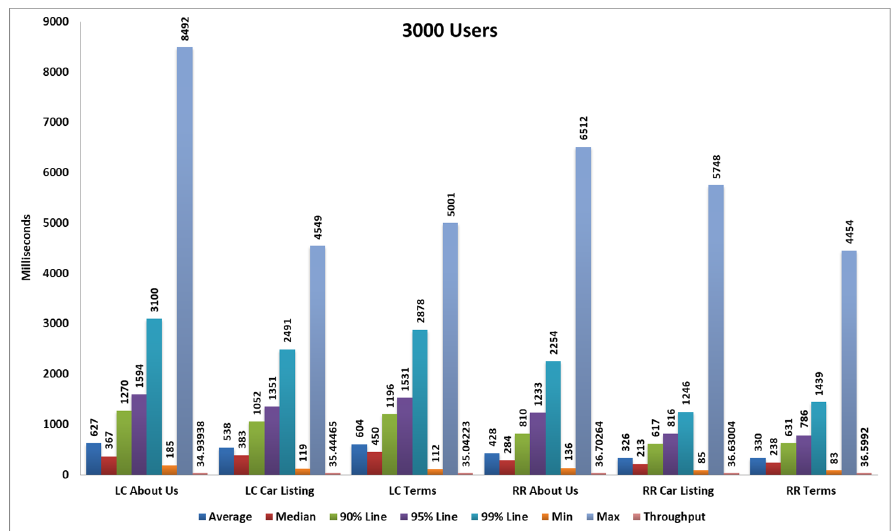
Figure 14. Aggregate graph using Table 4 data, showing the average response time, median, 90%, 95%, 99%, min, max, and throughput parameter of combined graph of the RR and LC algorithms. Sensors 2020 , 20 , x FOR PEER REVIEW